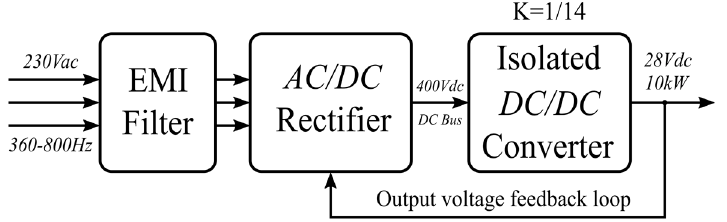
Figure 1. Aircraft active isolated rectifier architecture.